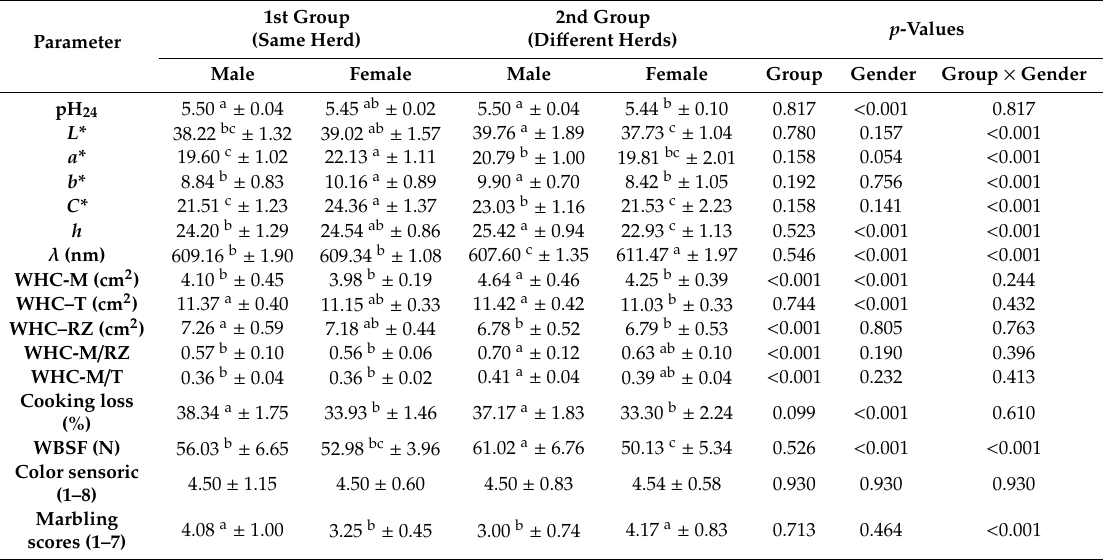
Table 3. Physical and sensory quality measurements of fresh and cooked M. longissimus lumborum from investigated groups of Simmental